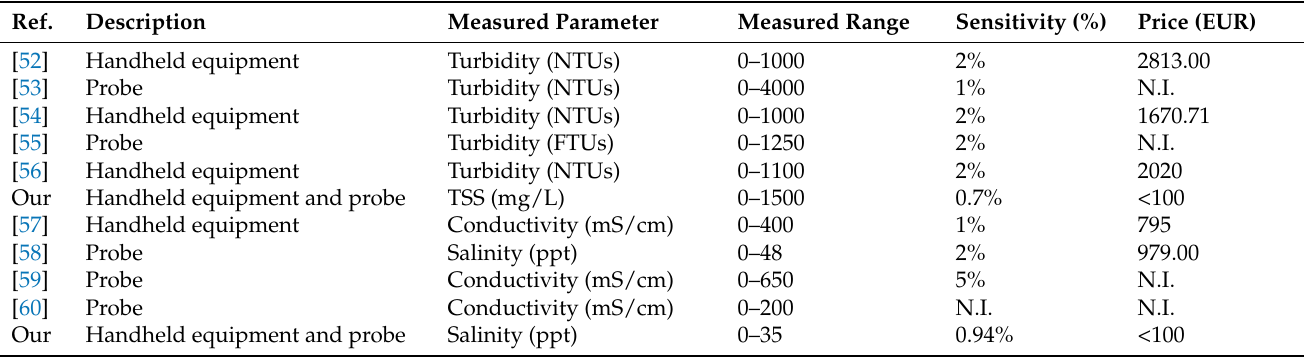
Table 5. Comparison with existing sensors in the